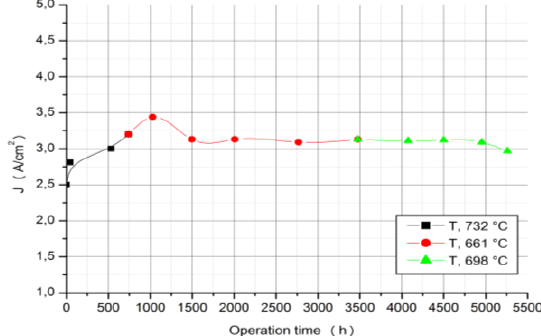
Fig. 6 . Plot of current density J (A / cm 2 ) as a function of the time t (h) of the MSDOC with M- coating deposited at the working gas pressure (Xe + CO 2 ) — 0.075-0.08 Pa; T is the work temperature of the MSDOC , °С